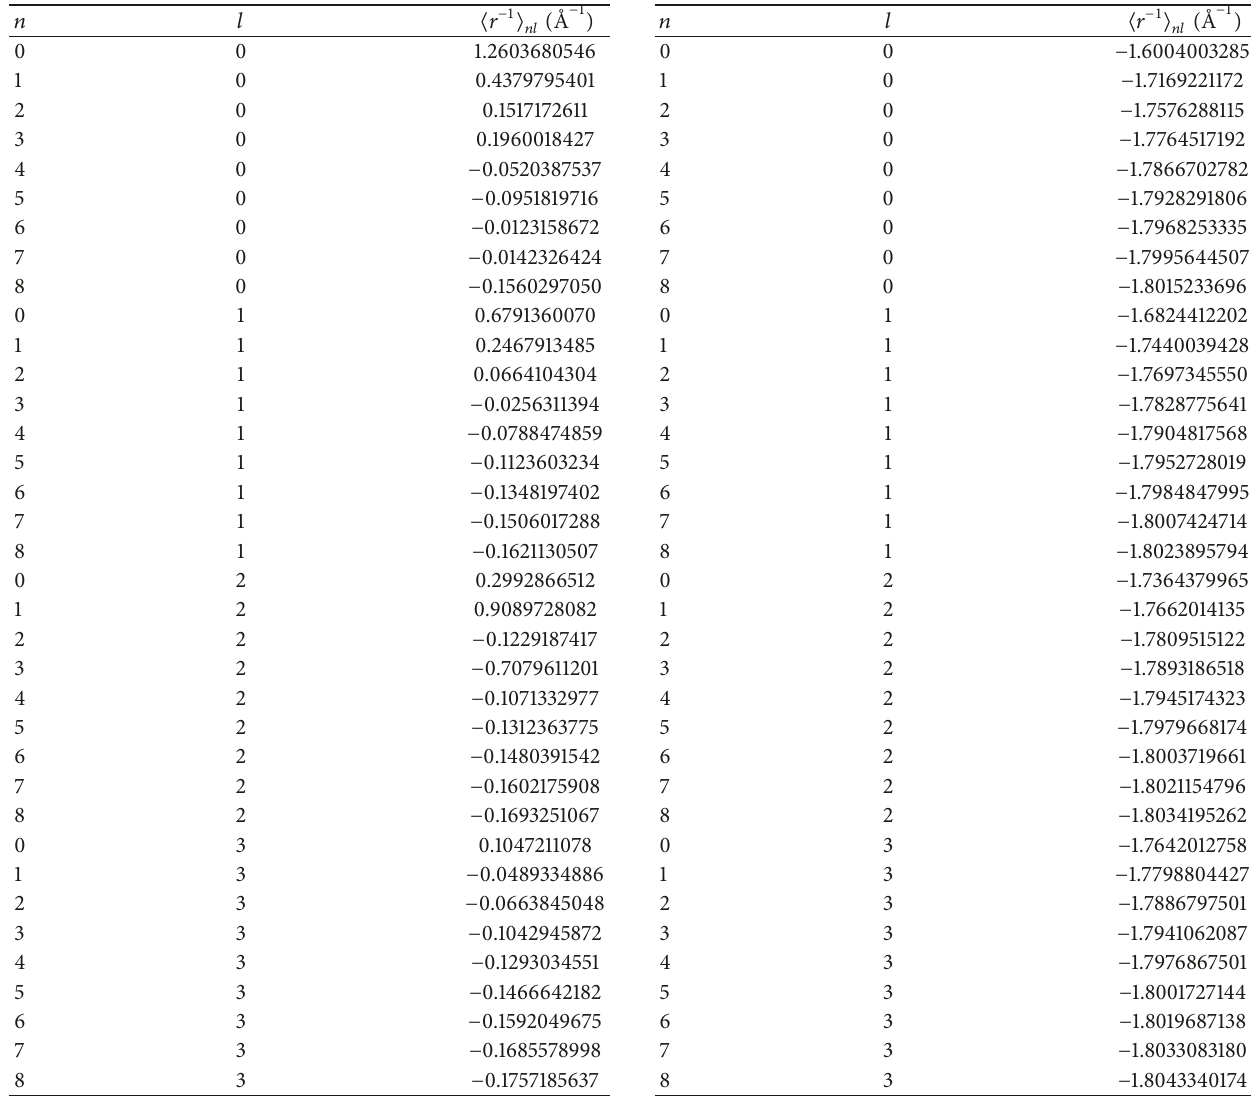
Table 6: Expectation values of ⟨𝑟 −1 ⟩ for hydrogen molecule. Table 7: Expectation values of ⟨𝑟 −1 ⟩ for lithium hydride